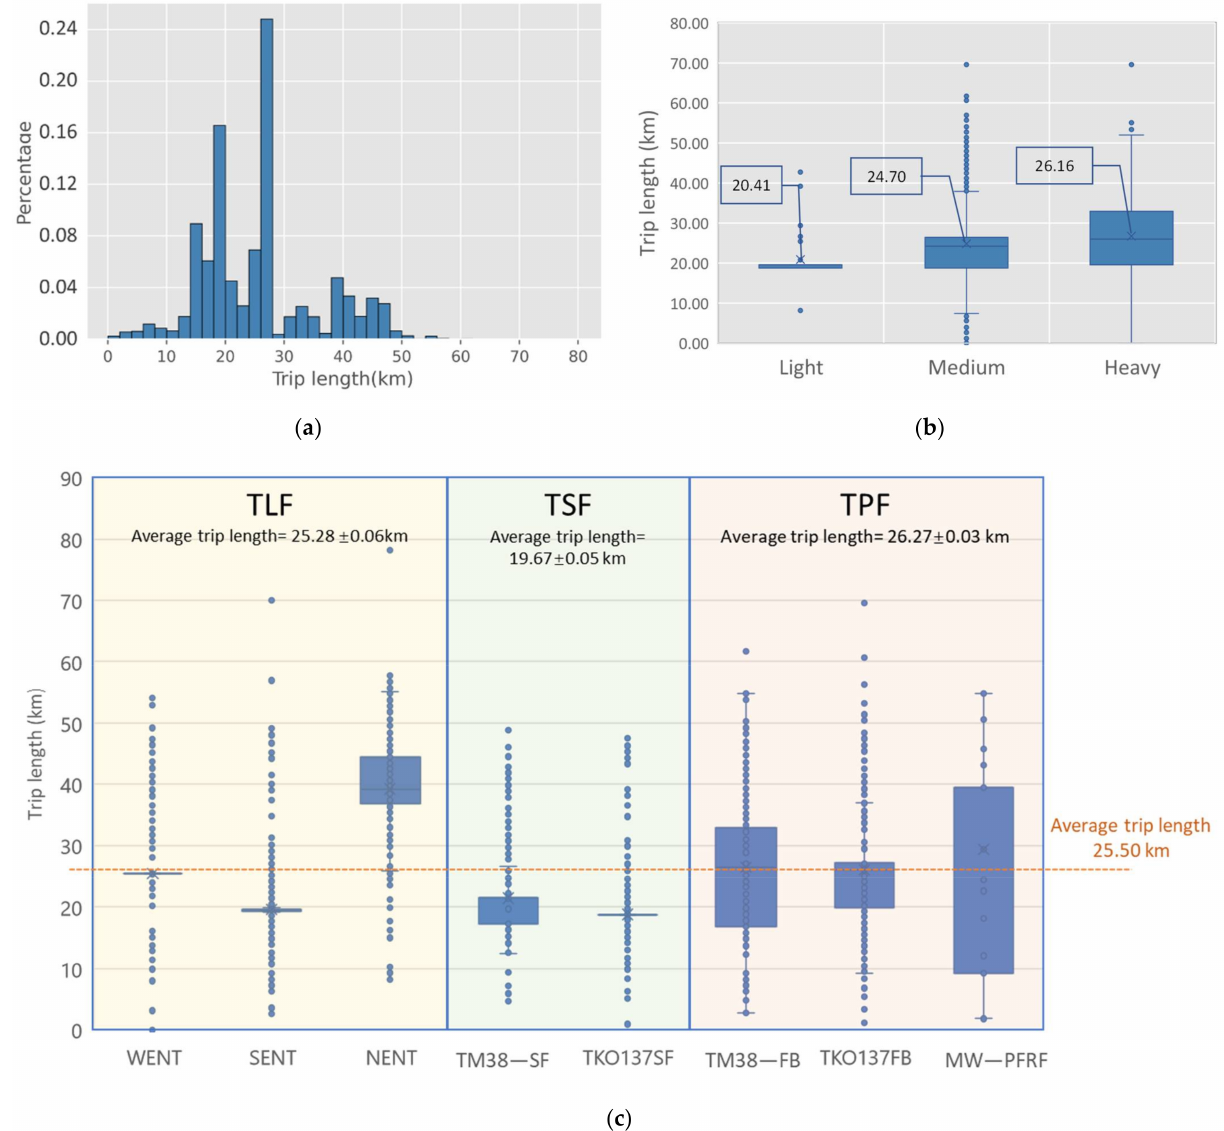
Figure 6. Trip length of CWHTs: ( a ) trip length histograms of CWHTs; ( b ) trip length distribution by vehicle types; ( c ) trip length distribution by freight trip types. Notes: Average trip length in ( c ) is presented as mean ± SEM (standard error of the